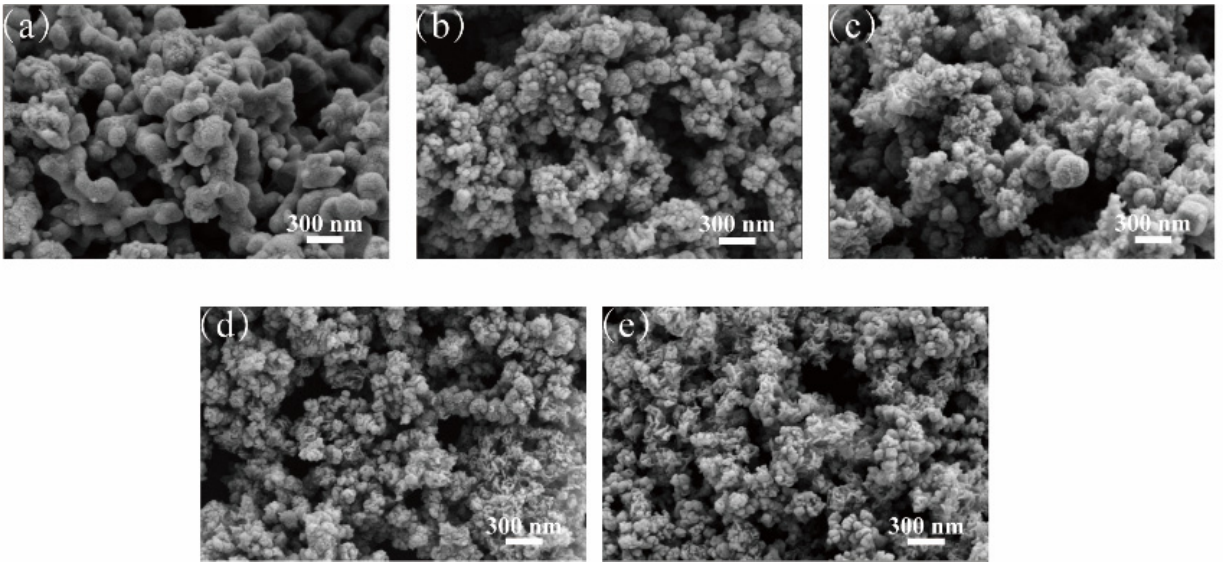
Figure 1. SEM images of nZVI and S-nZVI materials with different Fe/S molar ratios ( a ) nZVI; ( b ) S-nZVI (Fe/S = 10); ( c ) S-nZVI (Fe/S = 7.5); ( d ) S-nZVI (Fe/S = 5); ( e ) S-nZVI (Fe/S = 2.5).